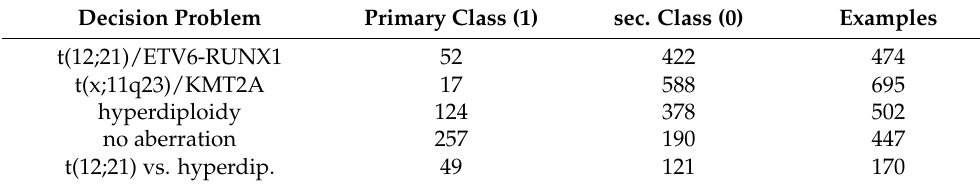
Table 2. Analysed data sets characteristics—decision class